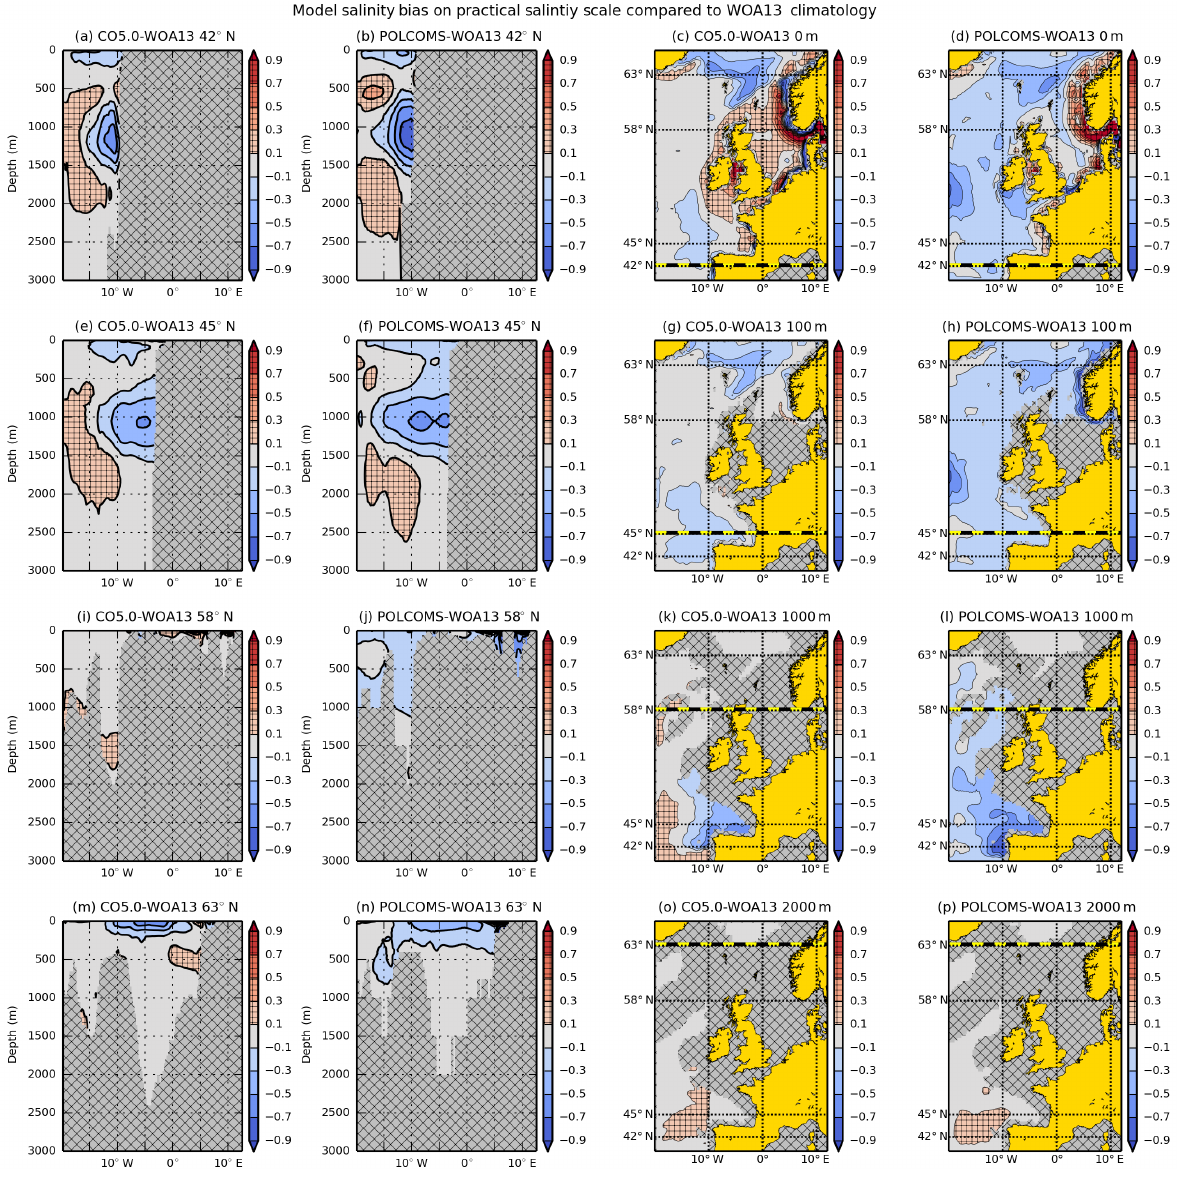
Figure 9. CO5 and POLCOMS salinity bias compared to WOA13 for 1985–2005. Panels (a) , (e) , (i) and (m) are CO5 – WOA13 salinity bias transects along 42, 45, 58 and 63 ◦ N. Panels (b) , (f) , (j) and (n) are POLCOMS – WOA13 salinity bias transects along 42, 45, 58 and 63 ◦ N. Panels (c) , (g) , (k) and (o) are the CO5 – WOA13 salinity bias at depths 0, 100, 1000 and 2000m. Panels (d) , (h) , (l) and (p) are the POLCOMS – WOA13 salinity bias at depths 0, 100, 1000 and